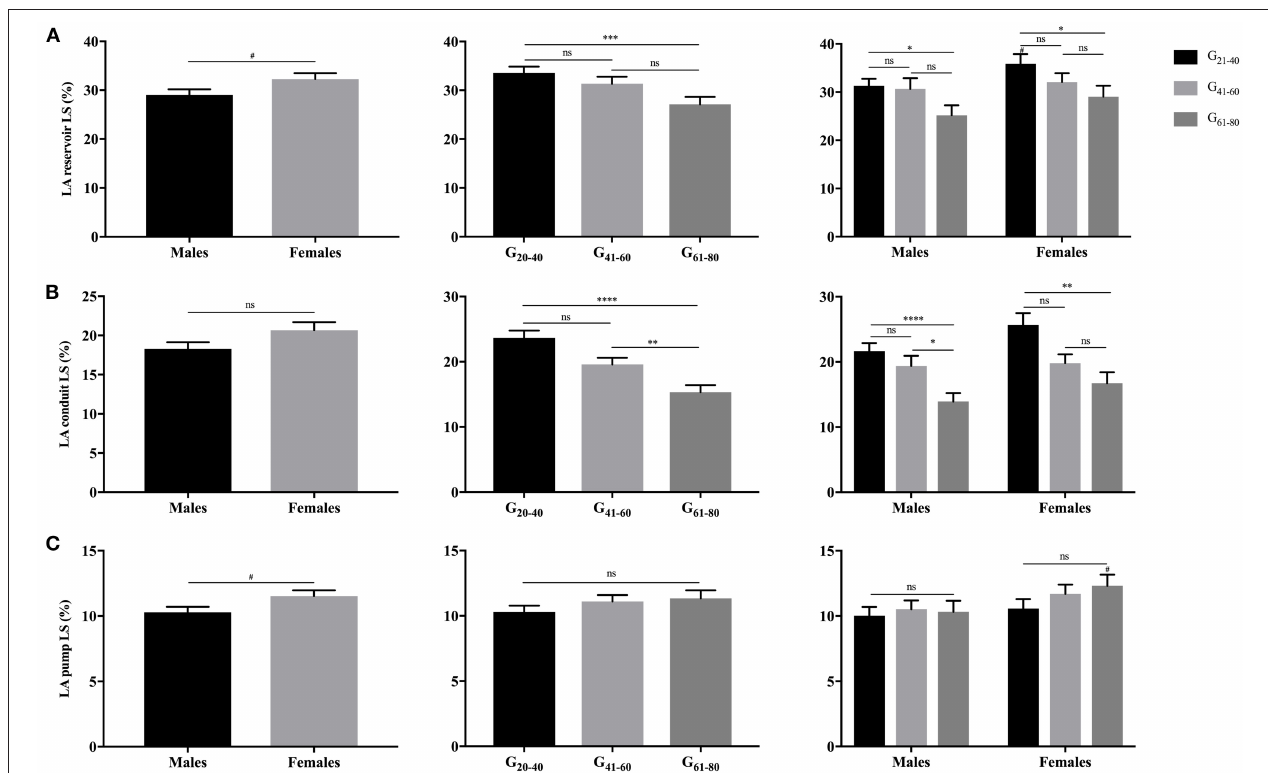
FIGURE 4 | Gender- and age-related differences of LA reservoir LS (A) , conduit LS (B) , and pump LS (C) . # P < 0.05: gender-related difference; * P < 0.05, ** P < 0.01, *** P < 0.001, **** P < 0.0001: age-related difference; ns: not significant.